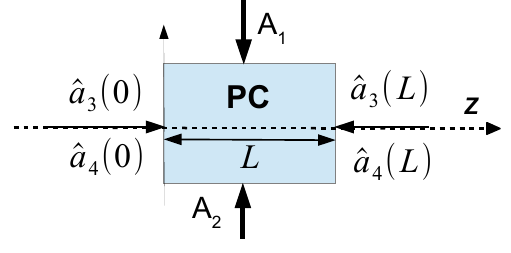
Figure 1. Four-wave mixing with two pump